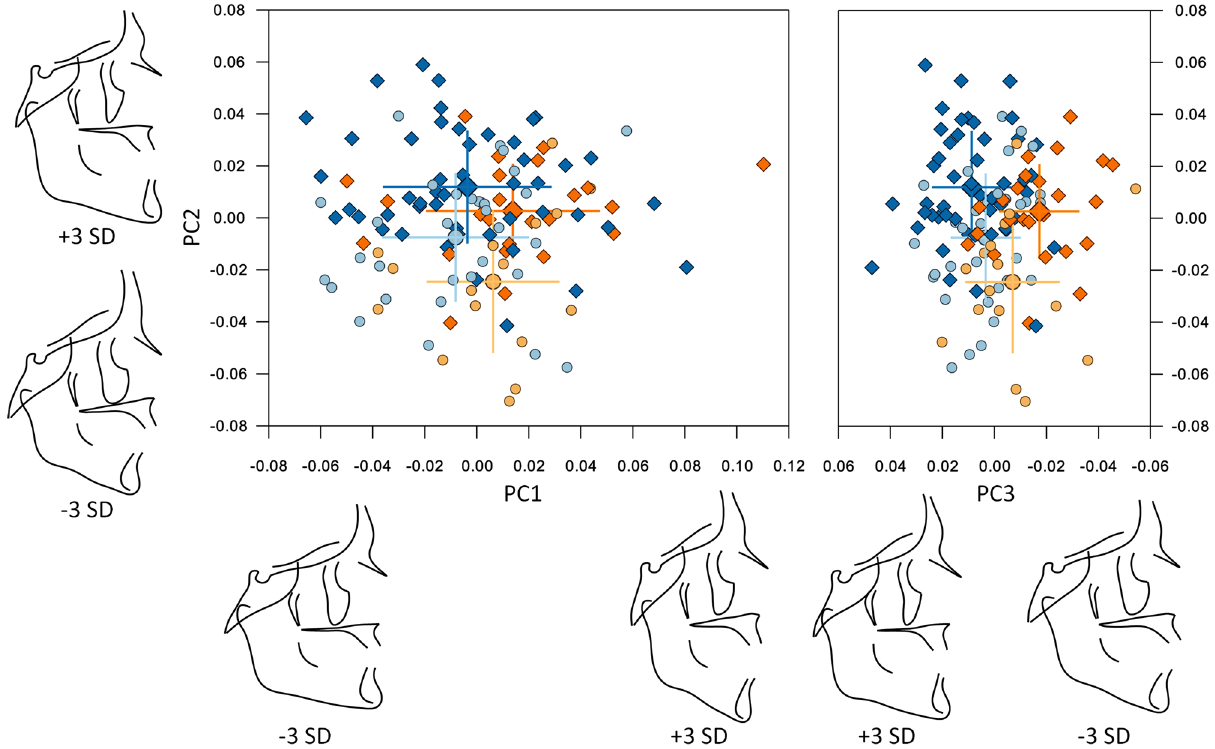
Figure 3. Composite of the shape space and first 3 PCs for the CrF region. Centre and right: the subjects plotted in the 3D shape space (centre: PC2 vs. PC1, right: PC2 vs. PC3). Blue and light blue: control subjects; orange and light orange: βTh group. Circles: females; diamonds: males. Large markers show group means with standard deviation lines. Axes scaling is in Procrustes distances from the average (all subjects scaled to a centroid size of 1). Left and bottom: the extreme shapes of variation along the PC1, PC2 and PC3 axes. Each extreme is + 3 or − 3 standard deviations from the average.